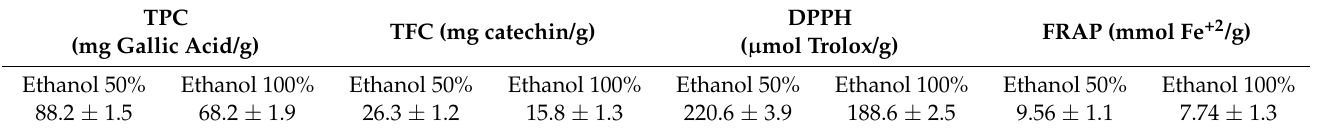
Table 3. Bioactive compounds determination and antioxidant activity of V. iphionoides extract.